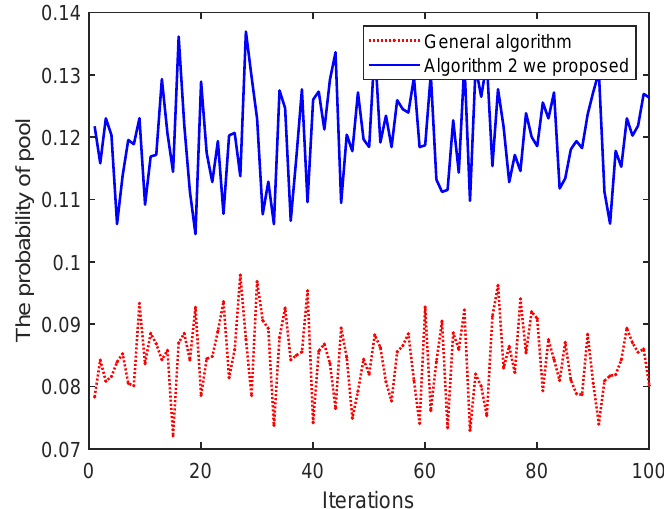
Figure 15. Iterations vs. The probability of pool.